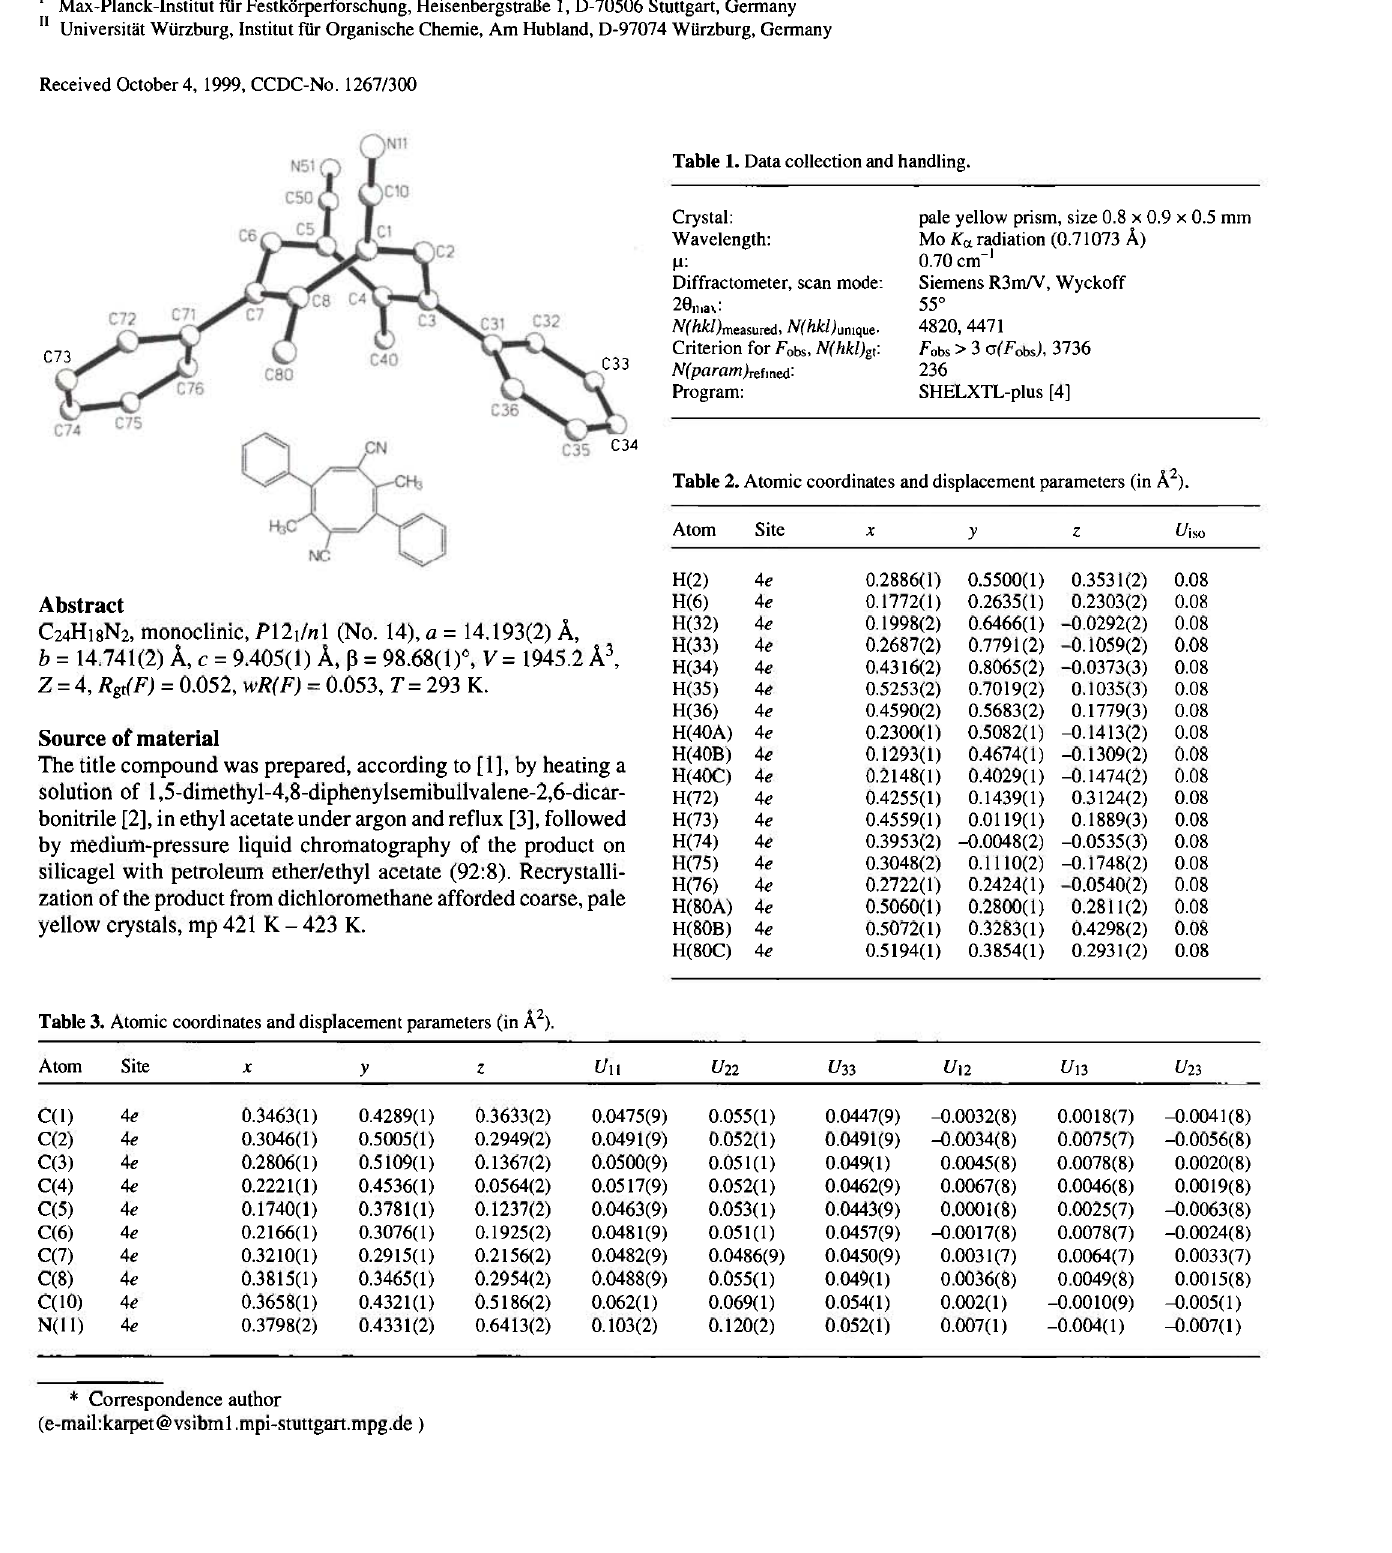
Table 1. Data collection and handling.